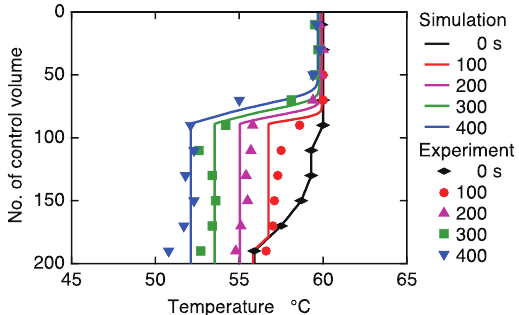
Figure 5. Experimental and simulated results in case B.